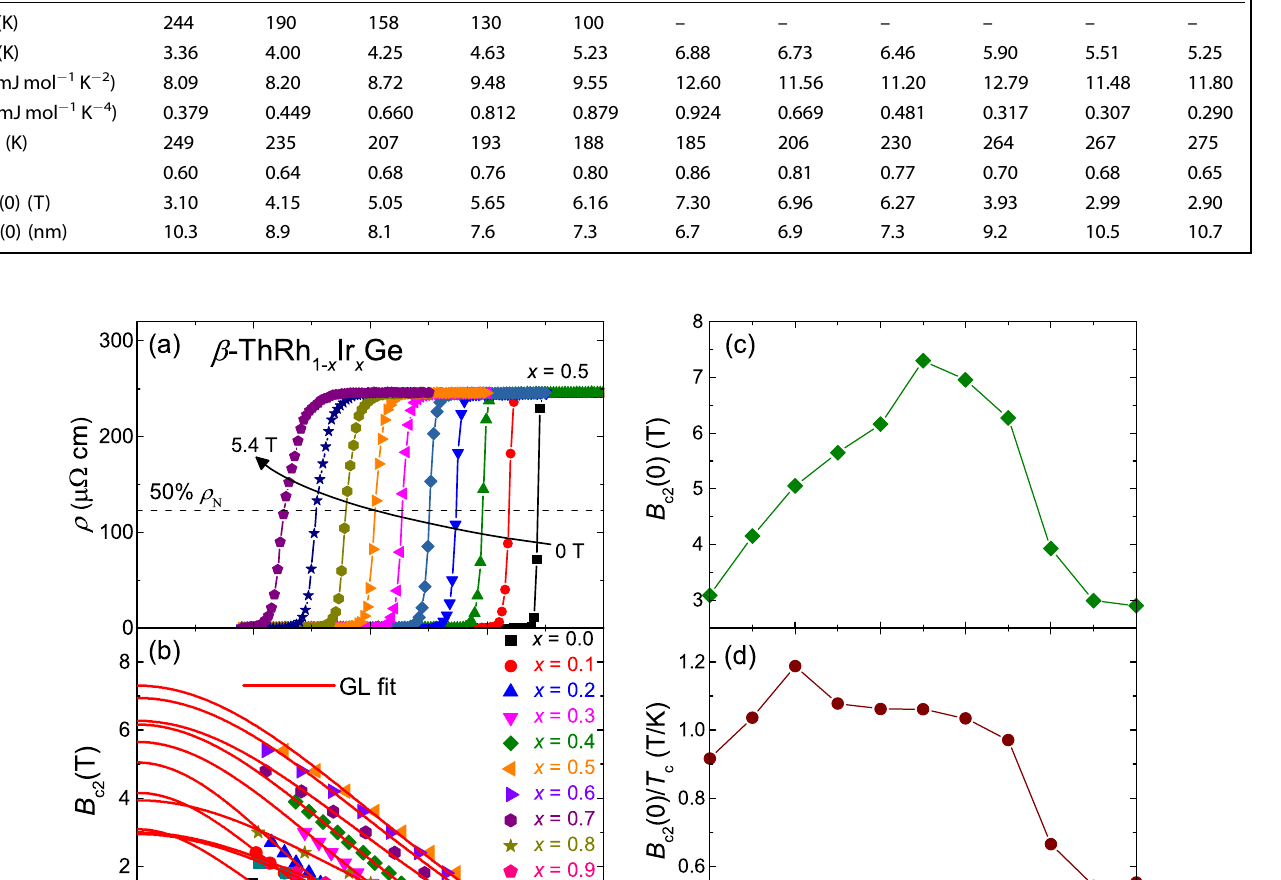
Table 1. Normal-state and superconducting parameters of β -ThRh 1 − x Ir x Ge. Parameter x = 0.0